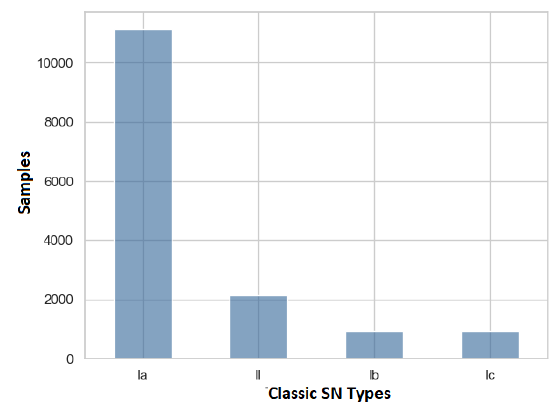
Figure 11. Classical SNe Types